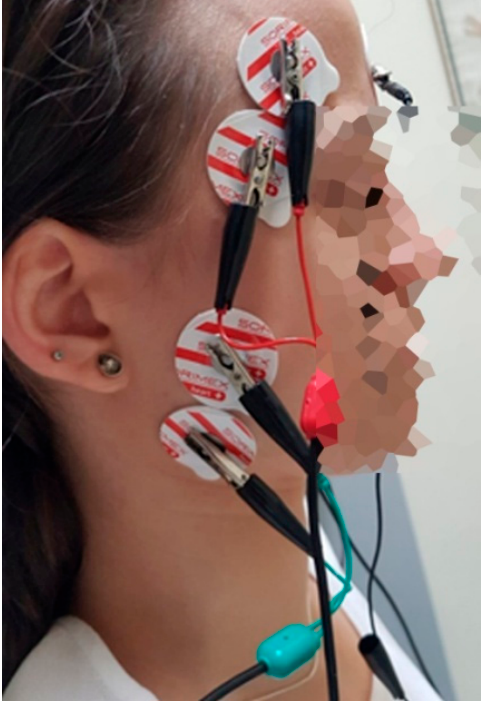
Figure 1. Electrodes placement during the electromyographic examination. The activity of the masticatory muscles (TA, MM) was recorded in the following protocol: during resting mandibular position (10 s), during maximum voluntary clenching (three clenches of 3 s, each with a 2-s break), during maximum voluntary clenching on dental cotton rollers (three clenches of 3 s, with a 2-s break) and during maximum mouth opening (three abductions of 3 s, with a 2-s rest between) [27,28]. The electromyographic signals were amplified and purified from 99% of the noise scale on a linear scale using the BioPak digital NoiseBuster